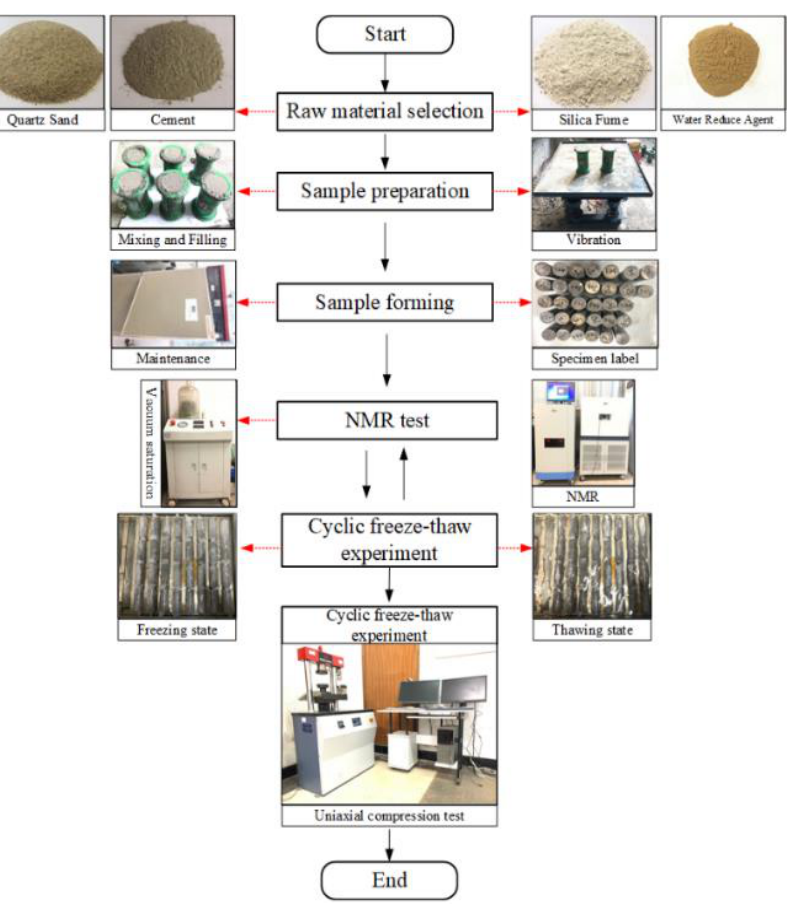
Figure 1. Test procedures. Table 3. Statistics test results of a sandstone-like material and sandstone.